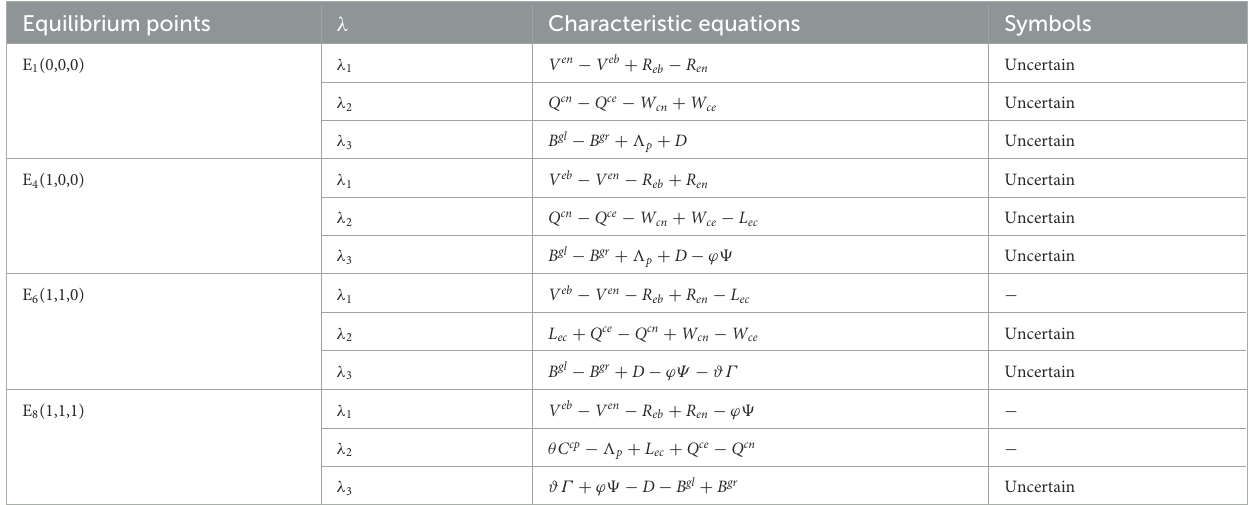
TABLE 3 Local stability analysis for equilibrium point. Equilibrium points λ Characteristic equations